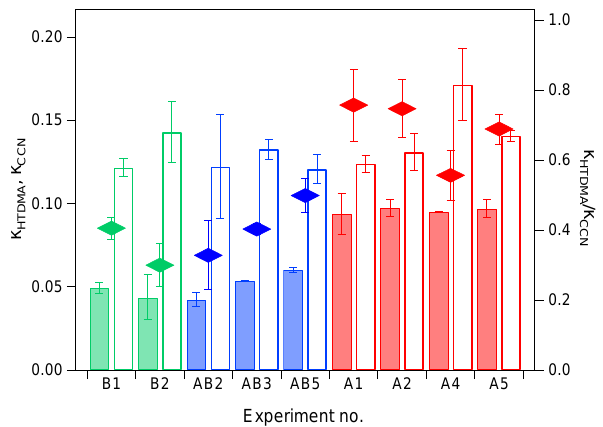
Figure 7. Comparison of κ HTDMA and κ CCN from HTDMA and CCN measurements for BSOA, ASOA, and ABSOA. The solid bar denotes the κ HTDMA and the open bar denotes κ CCN (left axis). The diamond denotes the ratio of κ HTDMA to κ CCN (right axis). The green, blue, and red colors indicate the BSOA, ABSOA, and ASOA, respectively. For all SOA here, there was a discrepancy between κ HTDMA and κ CCN . For ASOA, the gap between κ HTDMA and κ CCN (low κ HTDMA /κ CCN ) was smaller compared to